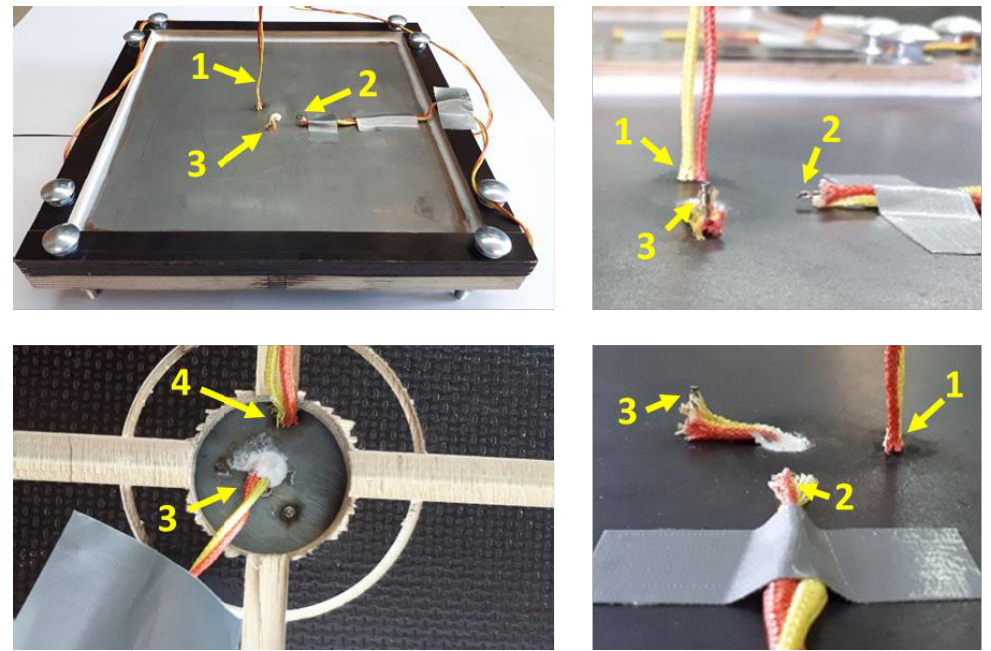
Figure 5. Identification of thermocouples, 1 – 4, on the specimen following Figure 4.